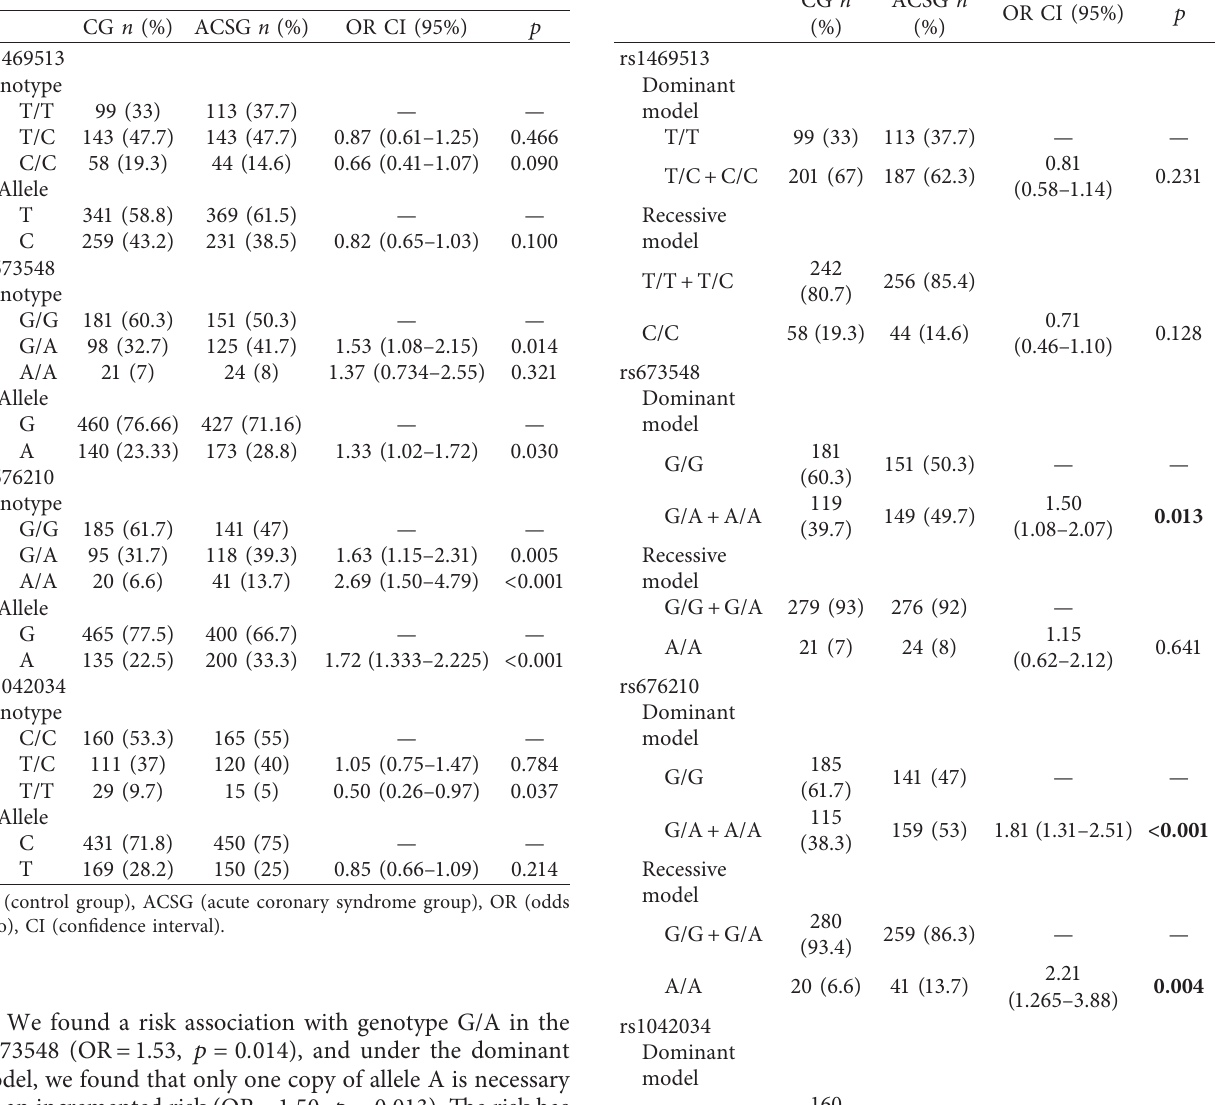
Table 3: Genotype and allele distribution of the rs1469513, rs673548, rs676210, and rs1042034 in the APOB gene in CG and ACSG.